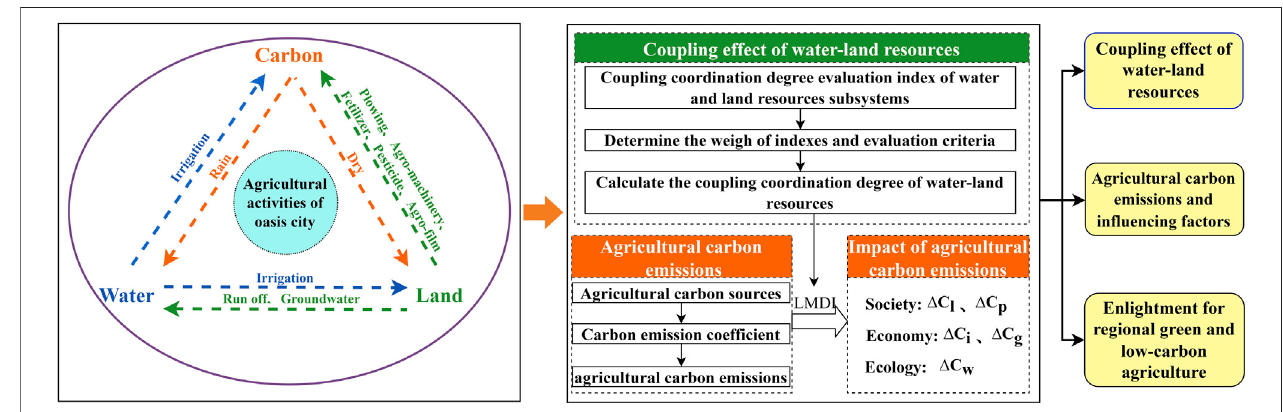
FIGURE 1 | System framework for impact factors of agricultural carbon emissions combined water – land resource coupling in the arid inland region.